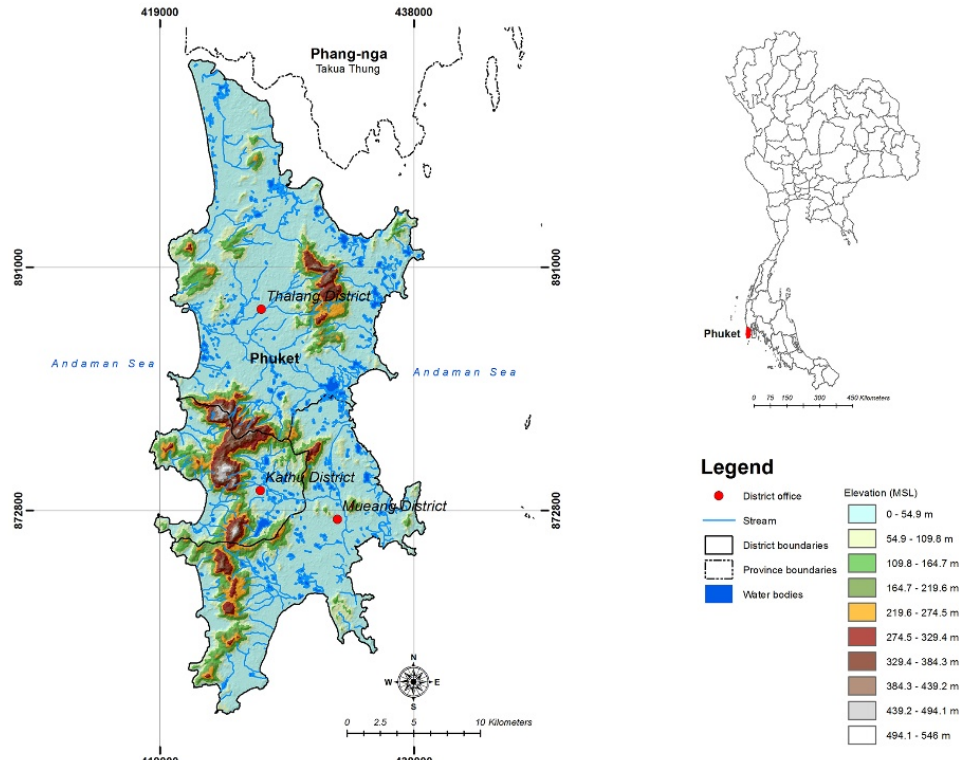
Figure 1. Elevation and topographic characteristics of the study